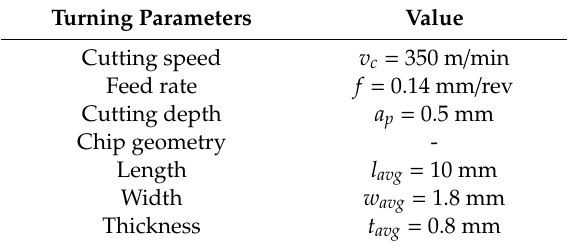
Table 3. Turning parameters for the fabrication of the chips and geometric chip characterization. Turning